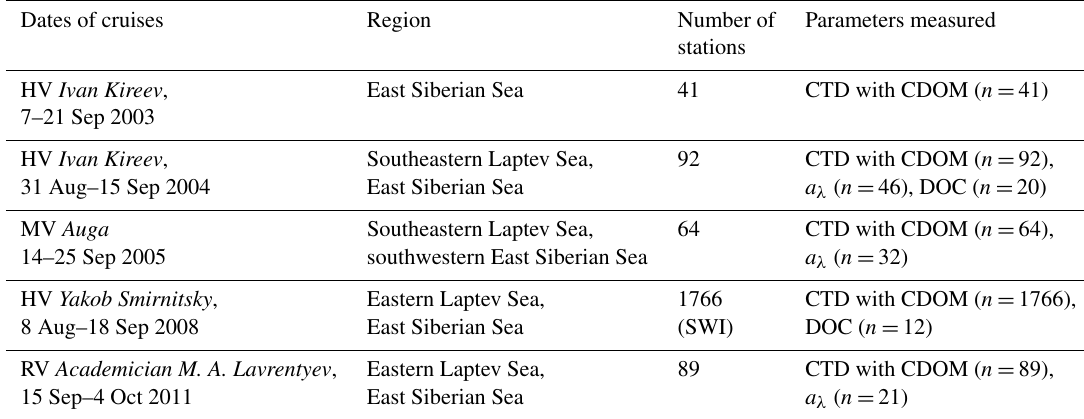
Table 1. Dates, number of stations, samples collected, and parameters measured in the surface layer during cruises. Dates of cruises Region Number of Parameters measured stations HV Ivan Kireev , East Siberian Sea 41 CTD with CDOM ( n = 41) Southeastern Laptev Sea, 92 CTD with CDOM ( n = 92), a λ ( n = 46), DOC ( n = 20) Southeastern Laptev Sea, 64 CTD with CDOM ( n = 64), a λ ( n = 32) Eastern Laptev Sea, 1766 CTD with CDOM ( n = 1766), East Siberian Sea (SWI) DOC ( n = 12) Eastern Laptev Sea, 89 CTD with CDOM ( n = 89), a λ ( n =